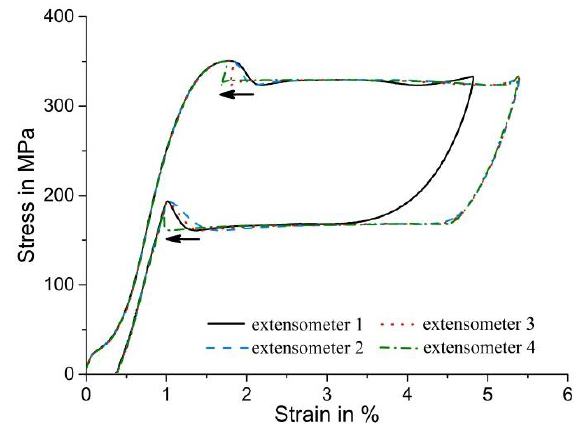
Figure 3. Engineering stress–strain curves determined using various virtual extensometers (see Figure 2) under uniaxial quasi-static tensile loading. The different extensometer positions with respect to the nucleation site of the martensite band lead to a systematic and significant effect on the resulting stress–strain curves, especially on the shape of the nucleation peak.